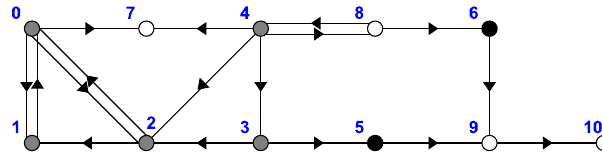
Figure 1: Common out-neighbor partition of a